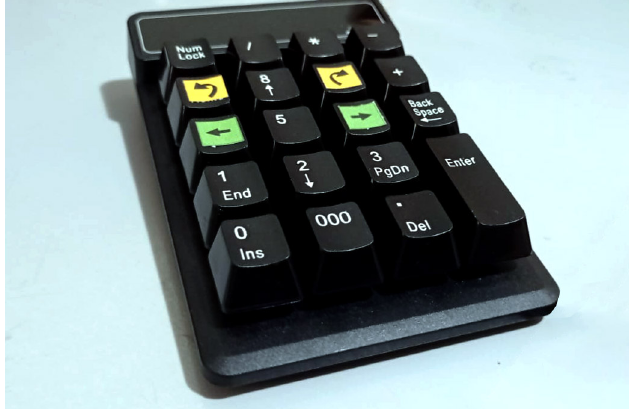
Figure 2. Numeric keypad used to control the